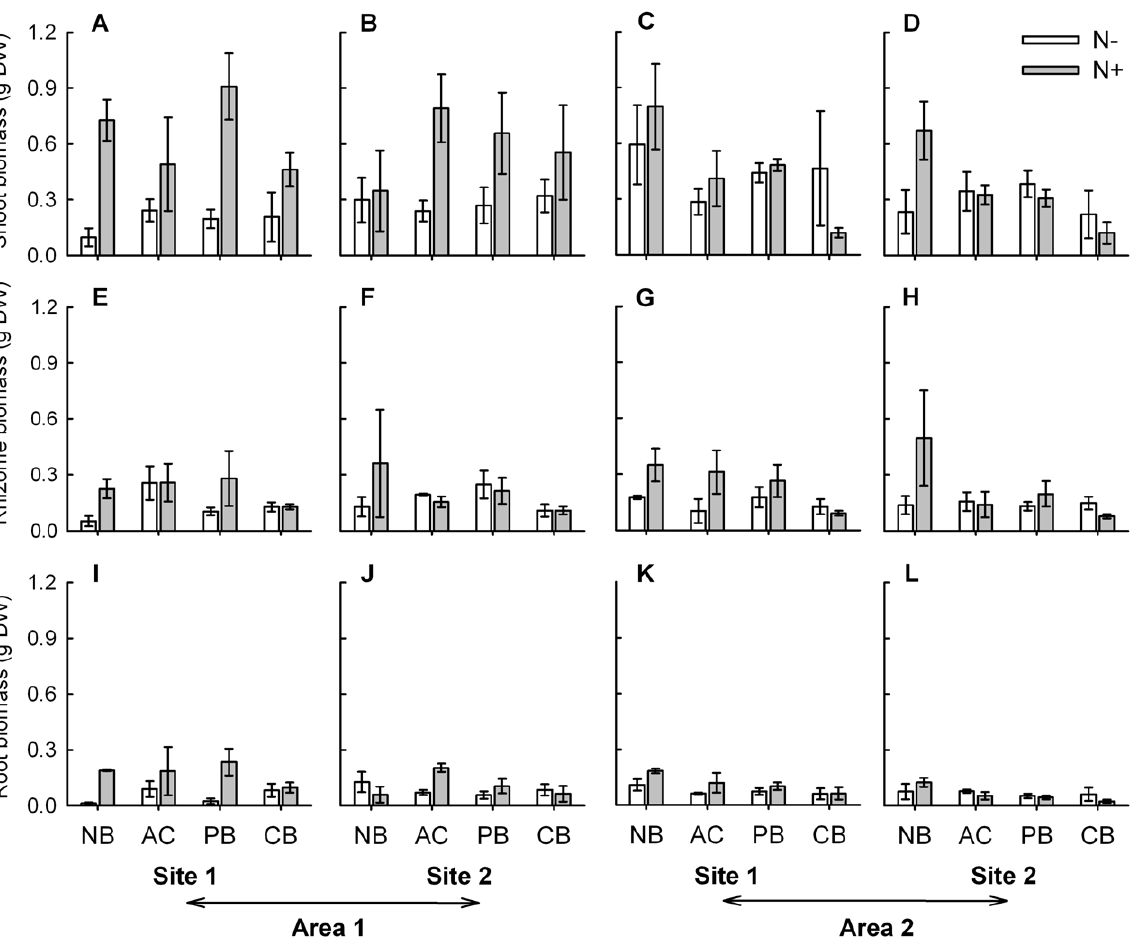
Figure 4. Biomass of main plant parts of Sporobolusvirginicus clones subjected to different experimental treatments. Mean ( 6 1 SE) biomass of shoots (A, B, C, D), rhizome (E, F, G, H) and roots (I, J, K, L) of plants grown in the two sites within each of the two areas. N 2 = no nutrient added, N + = nutrient addition; NB = no burial, AC = artifact control, PB = partial burial, CB = complete burial. n=3.